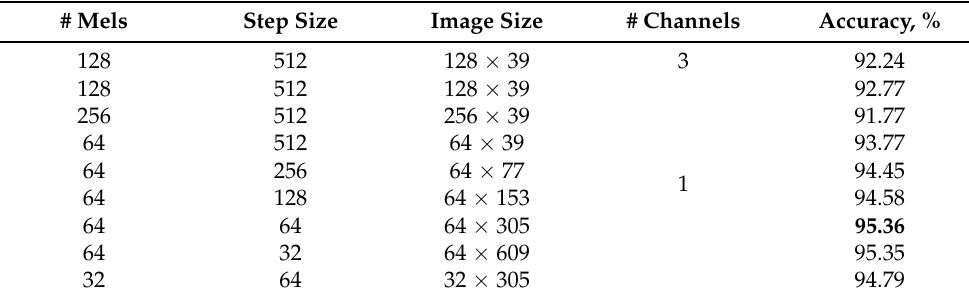
Table 7. Accuracy results of choosing the optimal parameters for log-Mel spectrogram.